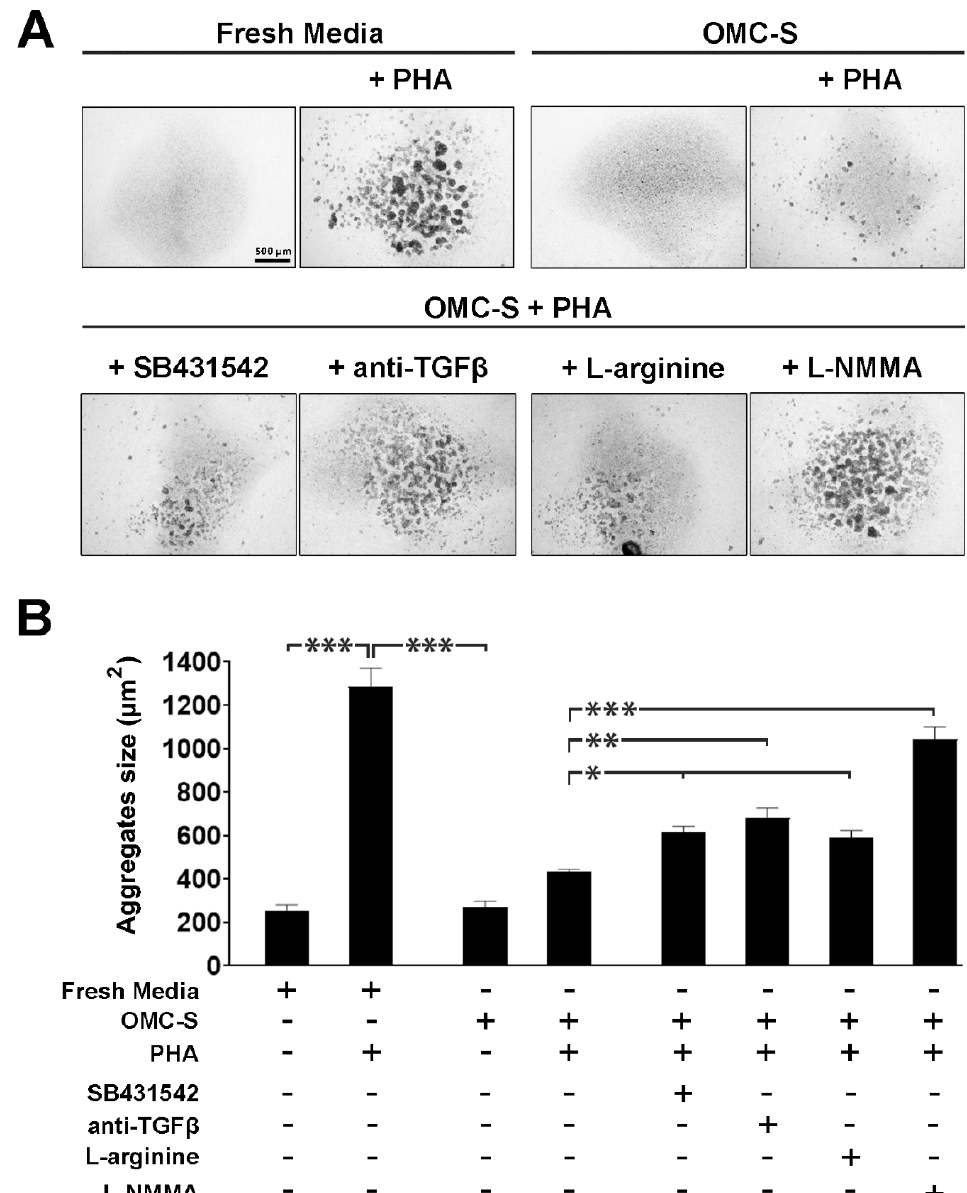
Figure 7. Lymphosuppression of OMC-derived secretome is partially mediated through TGF β , L- arginine, and induction of nitric oxide synthase (NOS) in lymphocytes. ( A ). Upper panels, low-mag- nification (2×) images of mouse lymph nodes (LN) lymphocytes cultured for 48 h in fresh media or OMC-derived secretome (OMC-S), with or without 25 µg/mL phytohemagglutinin (PHA). Scale bar: 500 µm. Lower panel, images of mouse LN lymphocytes cultured in the presence of OMC-S + PHA supplemented with 50 µM SB-431542 (selective inhibitor of ALK5/TGF- β 1 Receptor), 1 µg/mL of a mouse monoclonal anti-TGF- β 1, β 2, and β 3 antibody, 1 mM L-arginine, or 100 µM L-NMMA (spe- cific inhibitor of nitric oxide synthase). ( B ) Quantification of lymphocyte agglutination in response to the various experimental culture conditions by measuring mean particle size surface (µm 2 ). Re- sults shown are mean ± s.e.m from ( n = 3) distinct batches of OMC-S from ALIC1, SEV3, and SEV4. Statistical differences between experimental conditions were calculated using one way ANOVA. * is for p ≤ 0.05; ** for p ≤ 0.01; *** p ≤ 0.001.